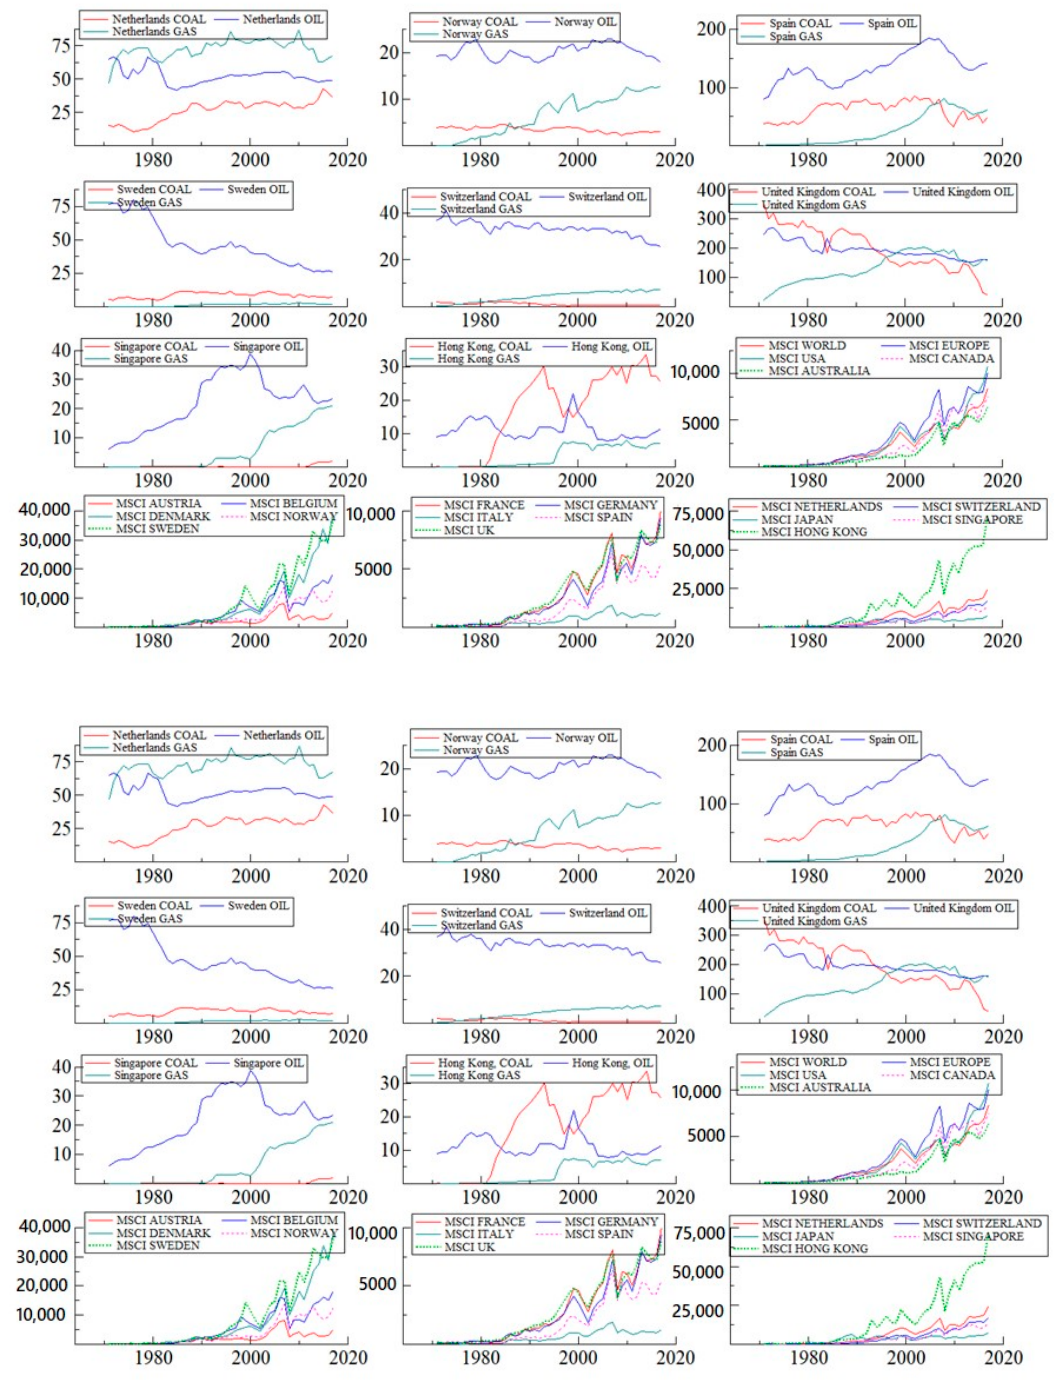
Figure 1. CO2 emissions from coal (red), oil (blue) and gas (turquoise) in 20 time series and MSCI stock indices for 1971–2017.